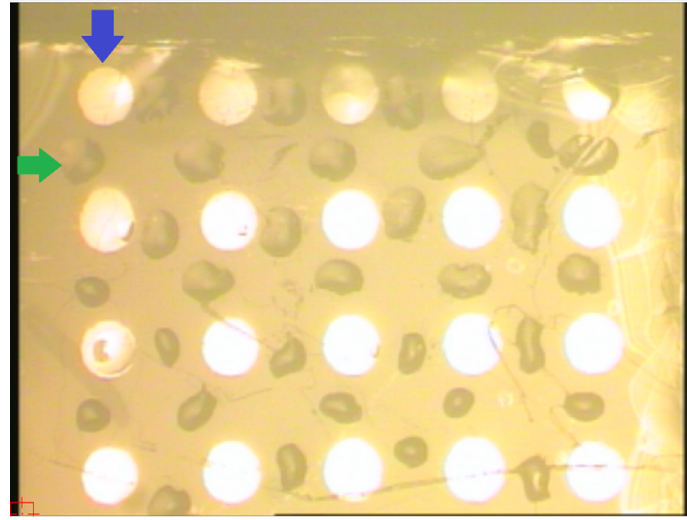
Figure 1. Optical image of the AFM chip surface bearing an array of sensor areas. Blue arrow indicates the magnetron-sputtered metallic mark. Green arrow indicates the micro-drop of the solution of an oligonucleotide probe dispensed with a Piezorray low-volume high-accuracy dispensing system (Perkin Elmer, Inc., Waltham, MA, USA). Each type of oligonucleotide probes was dispensed onto the surface of three separate sensor areas between the metallic marks. After the incubation of the AFM chip in the analyzed sample and subsequent washing, the AFM probe is positioned above the selected sensor area for scanning using the built-in AFM’s video system, and with the aid of a photographic image of the chip with the dispensed micro-drops.